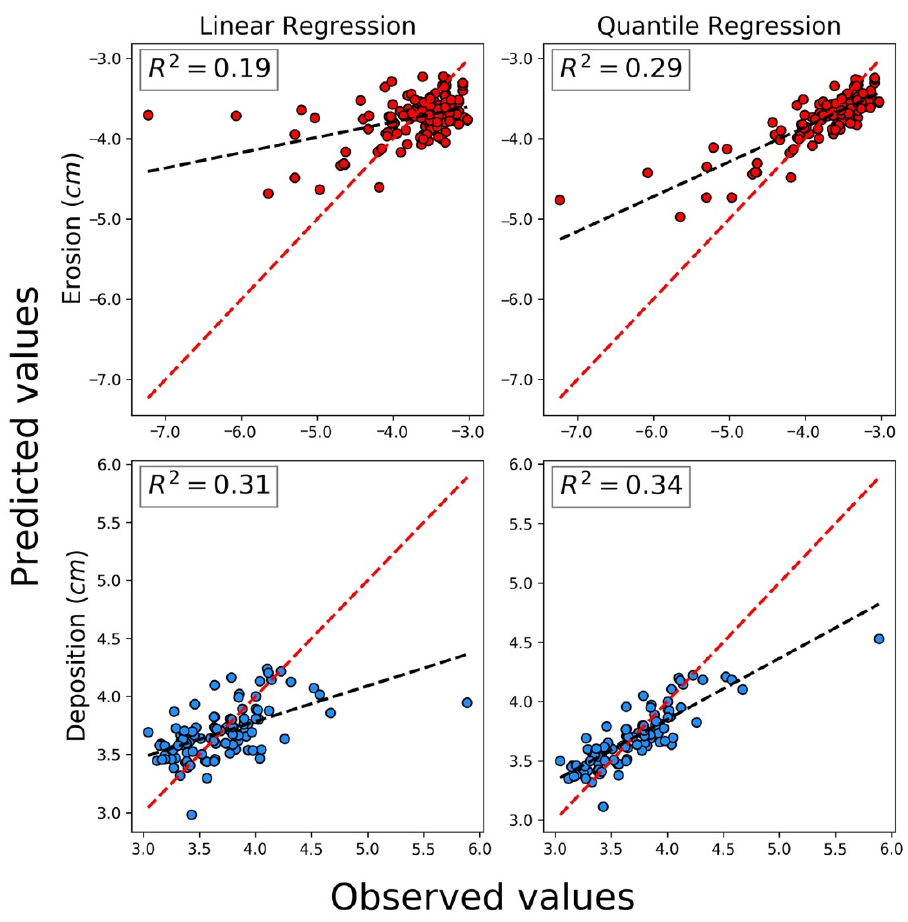
Figure 3. Predicted vs. observed erosion and deposition using OLS ( left ) and QR ( right ) models. The regression between predicted and observed values is shown in black dashed lines; the red dashed line represents the one-to-one line where y = x (perfect agreement).